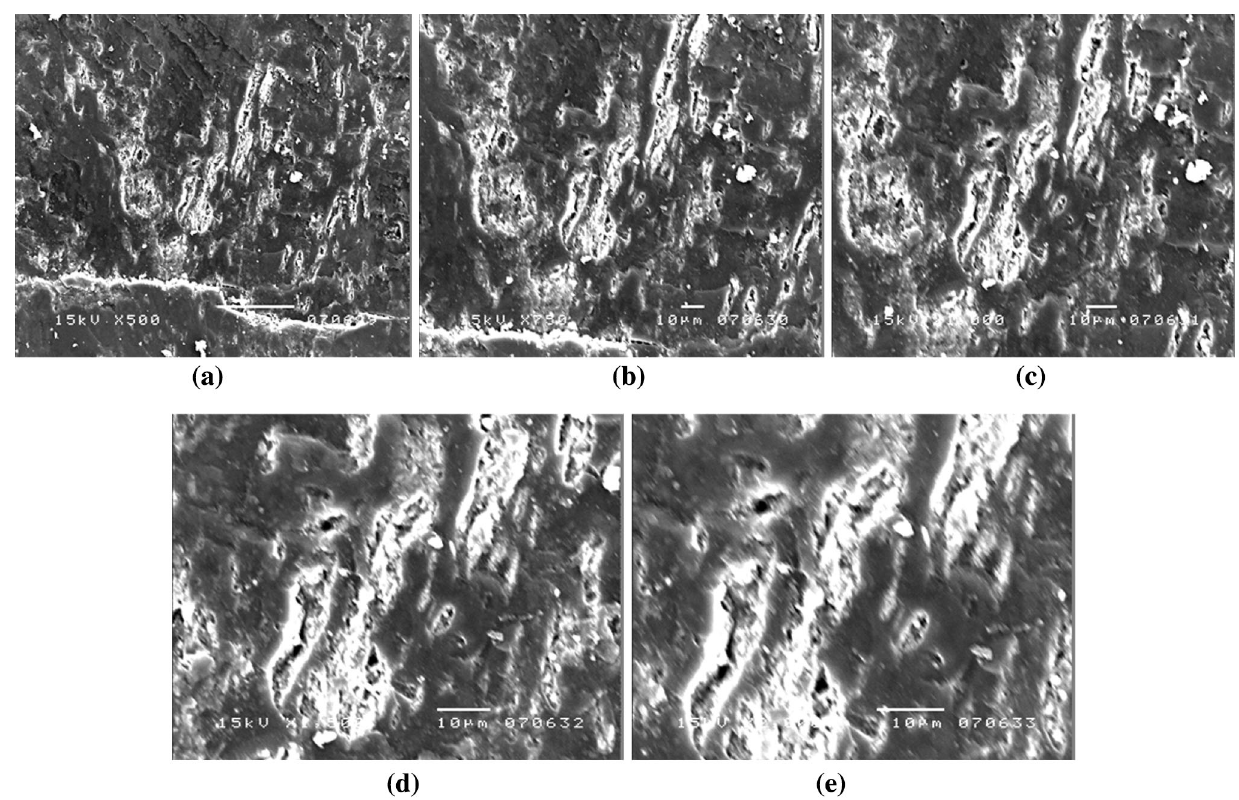
Fig. 1 SEM images of the No. 8 coal sample captured at different magnifications